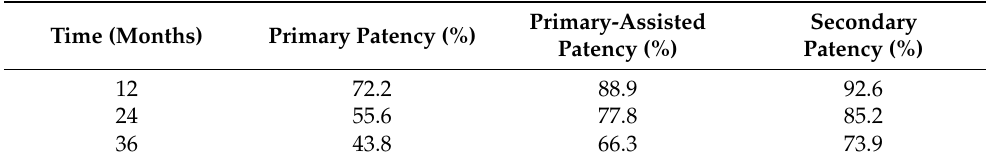
Table 2. Patency data summary at different time points throughout follow-up